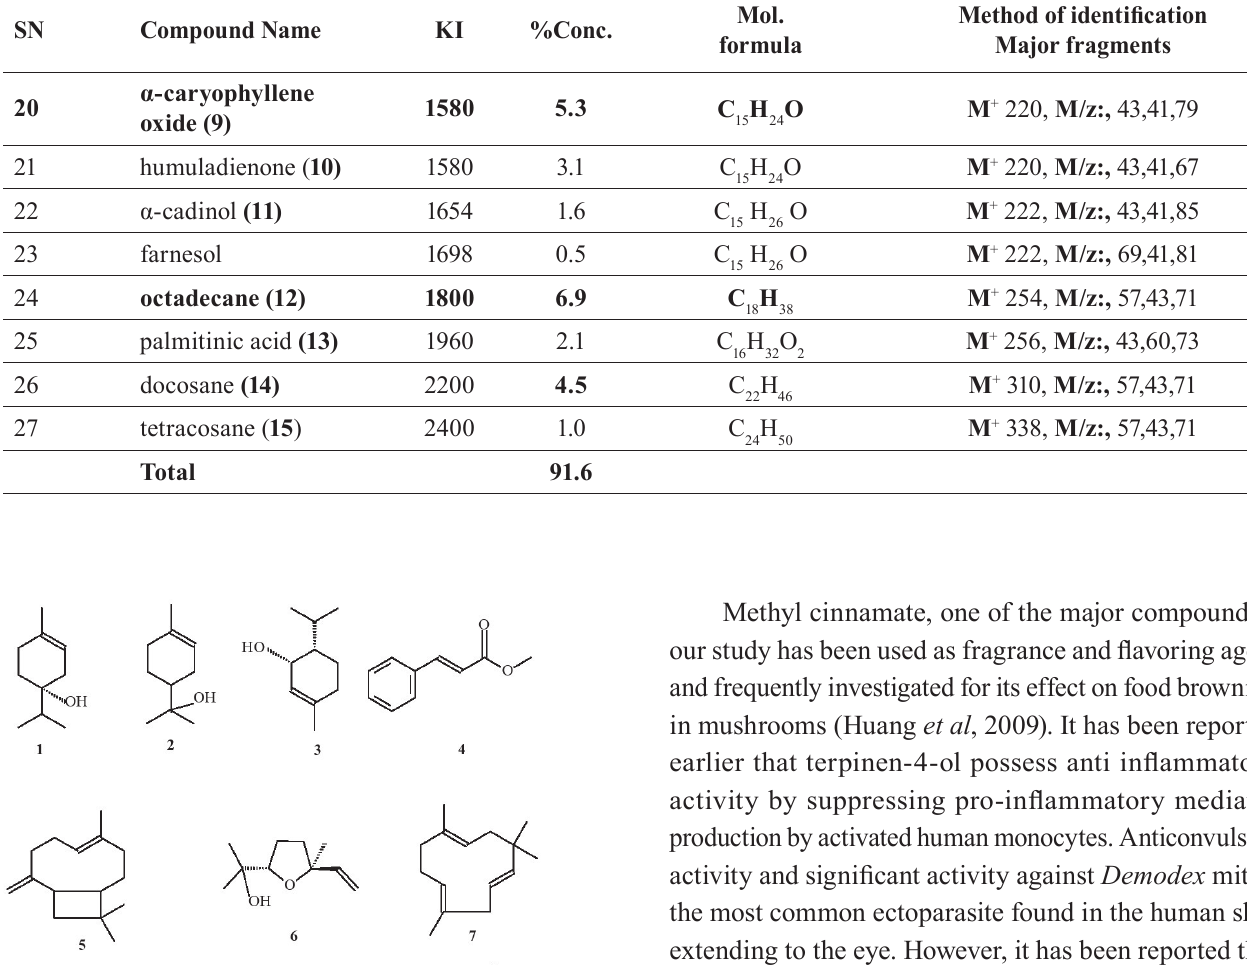
TABLE II - Chemical composition of AMFEO